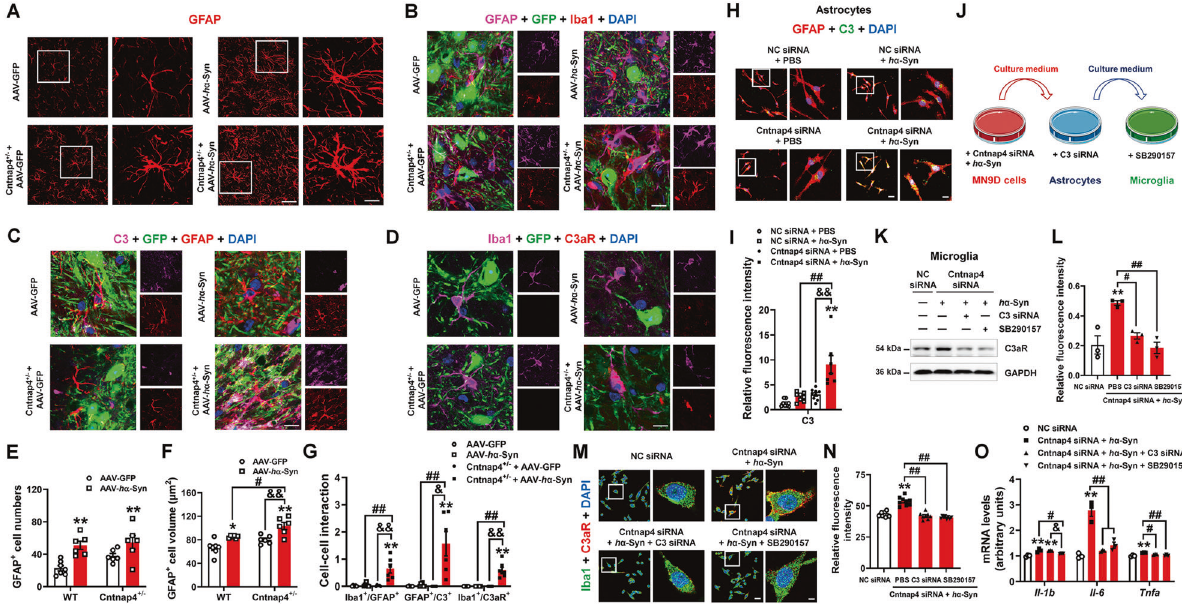
Fig. 4 Activation of the astrocyte – microglia C3-C3aR pathway in Cntnap4 partial de fi cient mice with α -synuclein overexpression. A Immuno fl uorescence staining of GFAP-positive cells in the SNpc of WT and Cntnap4 + / − mice injected with either AAV-GFP or AAV- h α -Syn. Scale bars: 20 μ m. Magni fi ed images of GFAP-positive cells in the SNpc are shown in the right column of panel A. Scale bars: 5 μ m. B – D Co- staining of GFAP with Iba1 ( B ), C3 with GFAP ( C ), and Iba1 with C3aR ( D ) in the SNpc of WT and Cntnap4 + / − mice injected with either AAV-GFP or AAV- h α -Syn. Scale bars: 40 μ m. Magni fi ed images are shown in the right column. Scale bars: 8 μ m. E , F Quanti fi cation of the cell number and volume of GFAP-positive cells in ( A ); n = 6 – 7. G Quanti fi cation of the interaction area of GFAP with Iba1 ( B ), C3 with GFAP ( C ), and Iba1 with C3aR ( D ); n = 5 – 7. H Co-staining of GFAP with C3 in astrocytes treated with the culture supernatant from MN9D cells (NC siRNA + PBS, NC siRNA + h α -Syn, Cntnap4 siRNA + PBS and Cntnap4 siRNA + h α -Syn). I Quanti fi cation of C3 intensity in panel ( H ); n = 7 – 9. J Schematic model showing the culture medium from Cntnap4 + / − or/both AAV- h α -Syn-treated MN9D cells to treat primary astrocytes. Then, the culture supernatant from astrocytes was used to treat primary microglia. C3 siRNA was used to treat astrocytes and SB290157 was used to treat microglia. K , L Microglia were treated with the culture supernatant from Cntnap4 siRNA + h α -Syn-treated astrocytes with C3 siRNA and SB290157. The protein expression level of C3 was determined by western blotting; n = 3 per group. M , N Co-staining of Iba1 with C3aR in the microglia from panel K; n = 8 – 11. O The mRNA expression levels of Il-1b , Il-6 , and Tnfa in the microglia from panel ( K ) were determined by qRT- PCR; n = 3 per group. Results are expressed as the mean ± SEM. ** p < 0.01, * p < 0.05 vs . WTor NC siRNA; ## p < 0.01, # p < 0.05 vs. AAV- h α -Syn, h α - Syn or Cntnap4 siRNA + h α -Syn; && p < 0.01, & p < 0.05 vs. Cntnap4 + / − , Cntnap4 siRNA, or Cntnap4 siRNA + h α -Syn + C3 siRNA. Statistical signi fi cance was determined using two-way ANOVA + Bonferroni ’ s multiple comparisons test ( E – G ), and one-way ANOVA + Tukey ’ s multiple comparisons test ( I , L , N , O